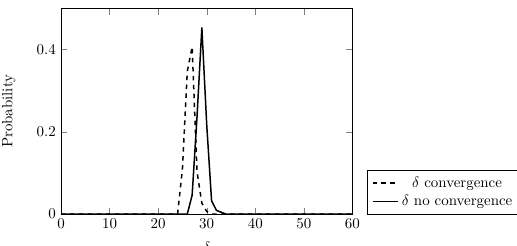
Figure 8: Distribution of δ when there is no convergence (plain) and when there is convergence (dashed) for real shuffled traces, using N = 1000 repetitions and 300 samples for each